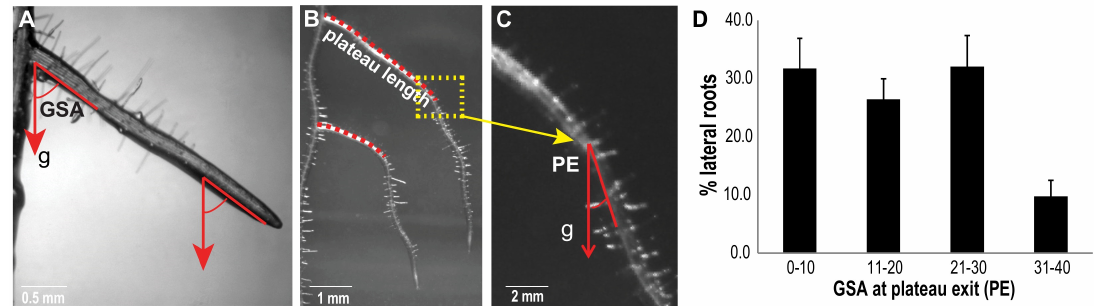
Figure 1. The gravitropic response at the plateau exit is highly variable. ( A ) During the plateau phase, or stage III, lateral roots (LRs) grow away from the parental root while keeping the initial (acquired in stage II) gravitropic set-point angle (GSA). Arrows denote the gravity (g) vector. ( B ) Two representative stage IV LRs are shown. Discontinuous red lines mark the length of their plateau trajectories. ( C ) Enlargement of the transit from stage III to IV, for the upper LR in B. ( D ) PE (GSA at plateau exit) distribution of Col-0 (wild type) LRs. Error bars represent SEM ( n = 6 experiments; each experiment with n ≥ 20 seedlings (40–60